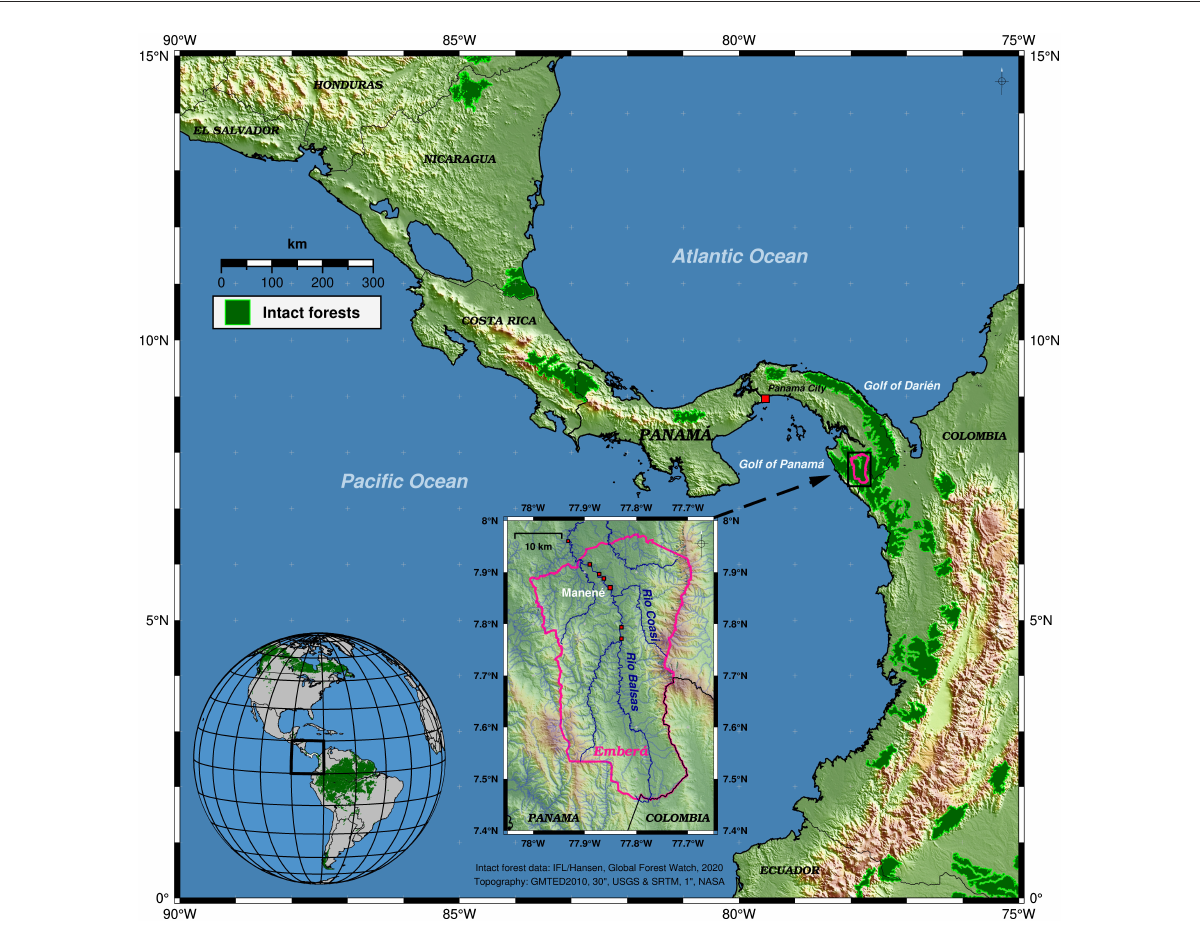
FIGURE1 Overview map of the study area within the Darién region of eastern Panama and the Emberá ( Tierras Colectivas del Río Balsas ) territory. Green polygons highlight areas with intact forests in 2020 according to the GlobalForestWatch platform (GFW, CC BY 4.0). The main study area (inset map) is centered along the Balsas and Coasí rivers. Colored hill-shaded topography (USGS GMTED2010/NASA STRM) and borders are shown for easier map